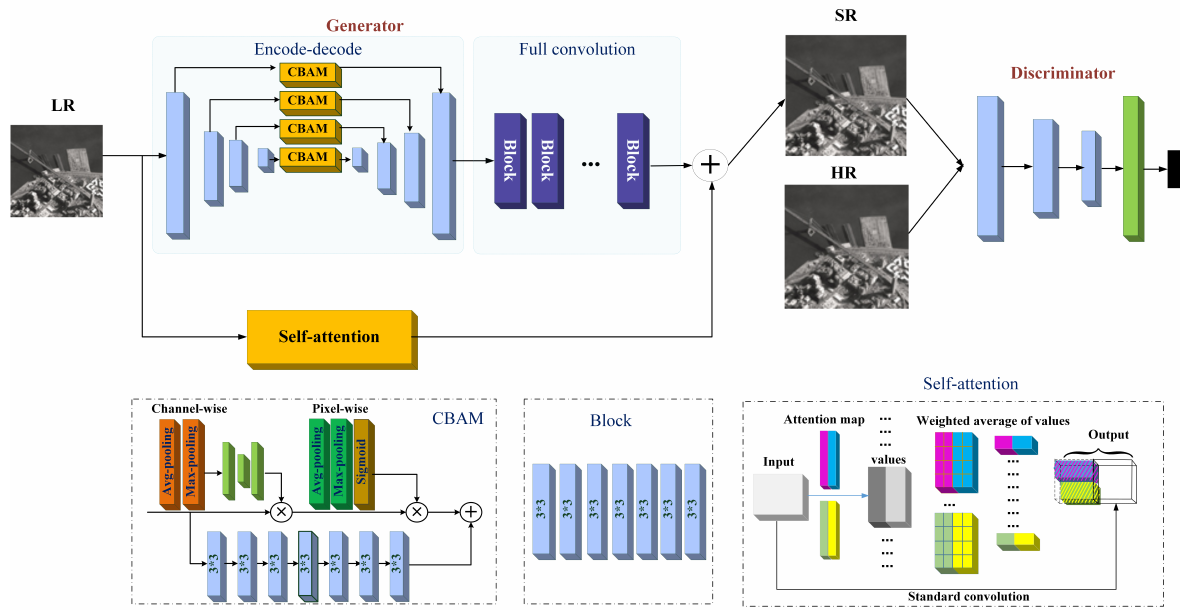
Figure 2. Architecture of self augmented attention